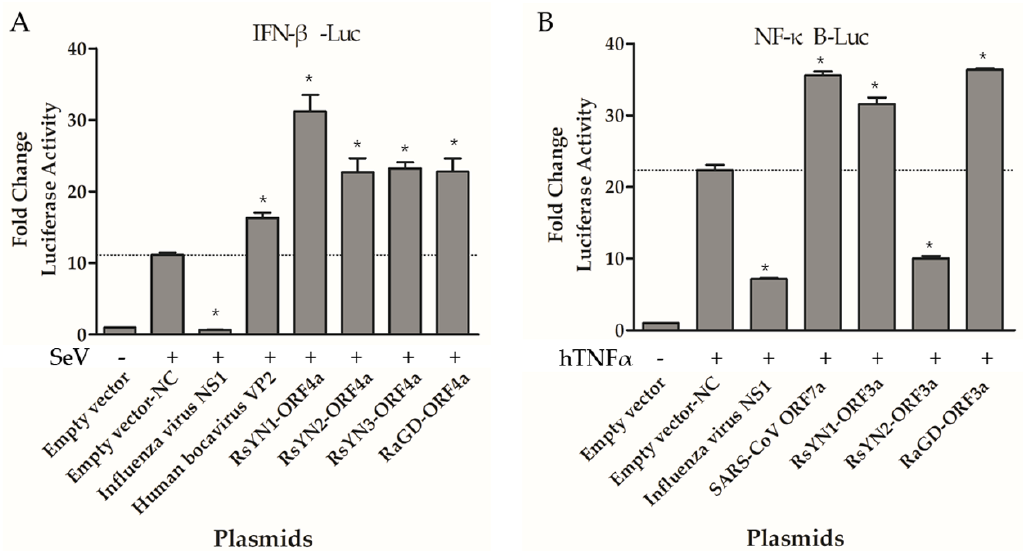
Figure 5. Functional analysis of BtCoV / Rh / YN2012 accessory genes. ( A ) ORF4a proteins inhibit the production of Type I interferon. 293T cells seeded in 24-well plates were transfected with 100 ng pIFN- β -Luc, 5 ng pRL-TK, empty vector (625 ng), an influenza A NS1-expressing plasmid (625 ng), a HBoV VP2-espressing plasmid (625 ng), or ORF4a-expressing plasmids (625 ng). The cells were infected with